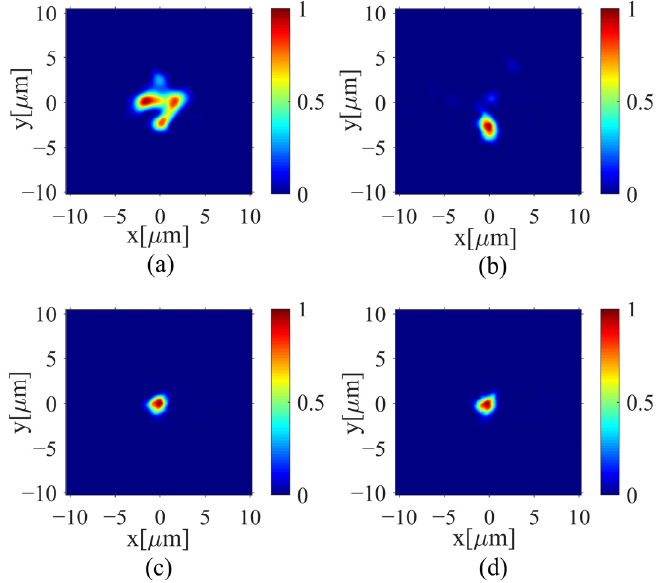
Figure 5. Optical field distribution of the novel G-DOF when X is equal to ( a ) 4 a , ( b ) 6 a , ( c ) 8 a , and ( d ) 10 a , respectively.